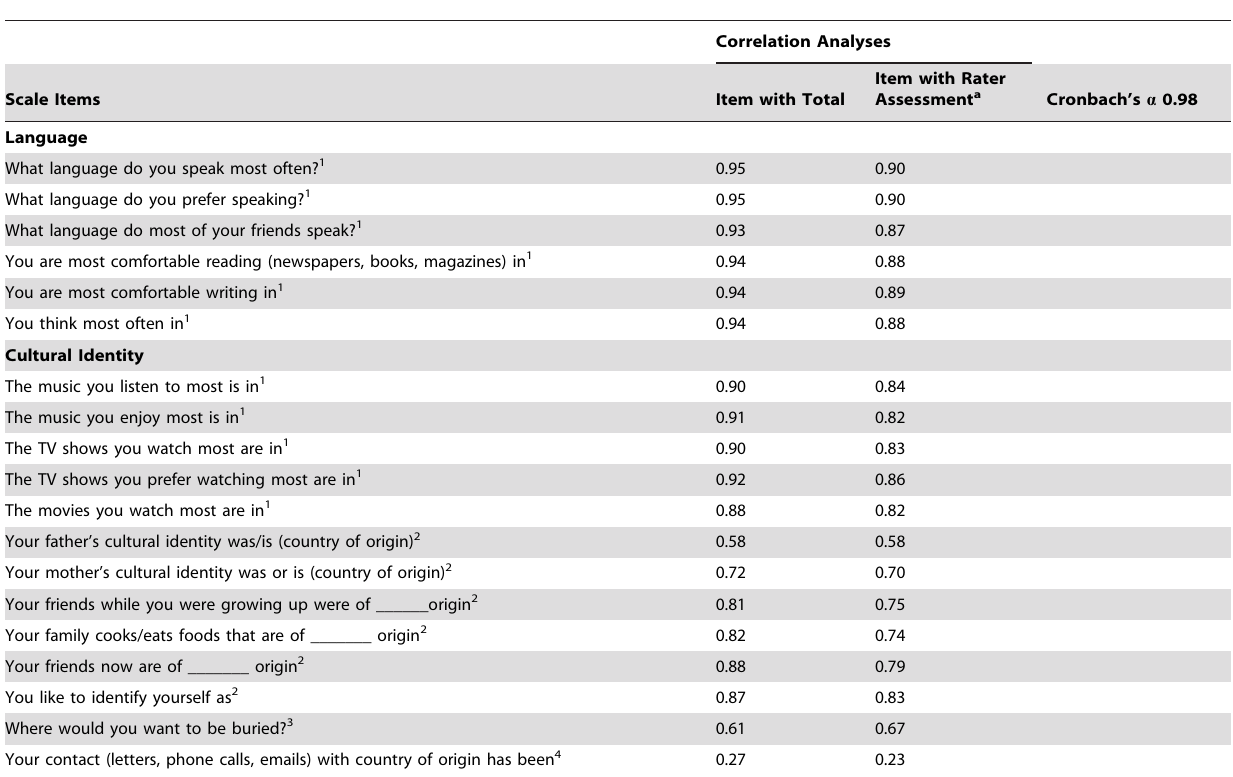
Table 1. United States acculturation scale.